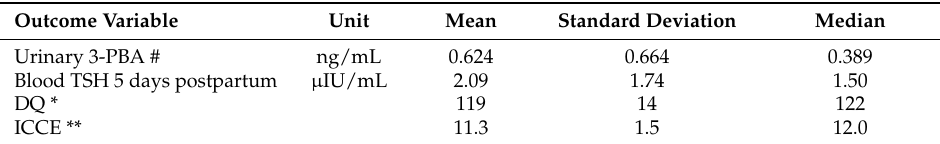
Table 2. Results of outcome variables ( n =